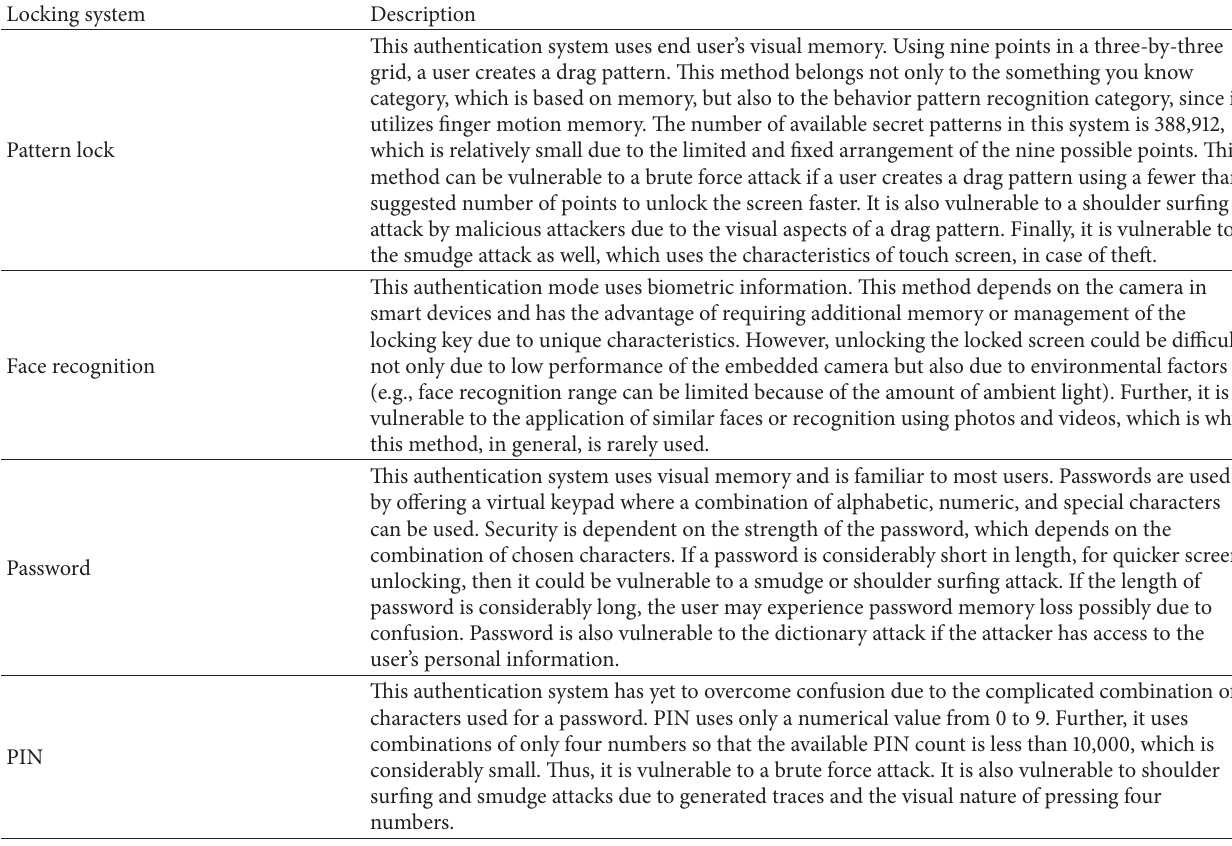
Table 2: Basic locking features embedded in smart